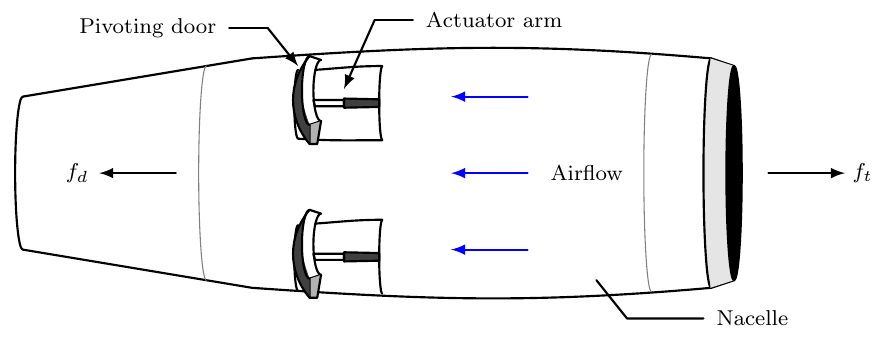
Figure 1. Notional illustration of pivoting-door